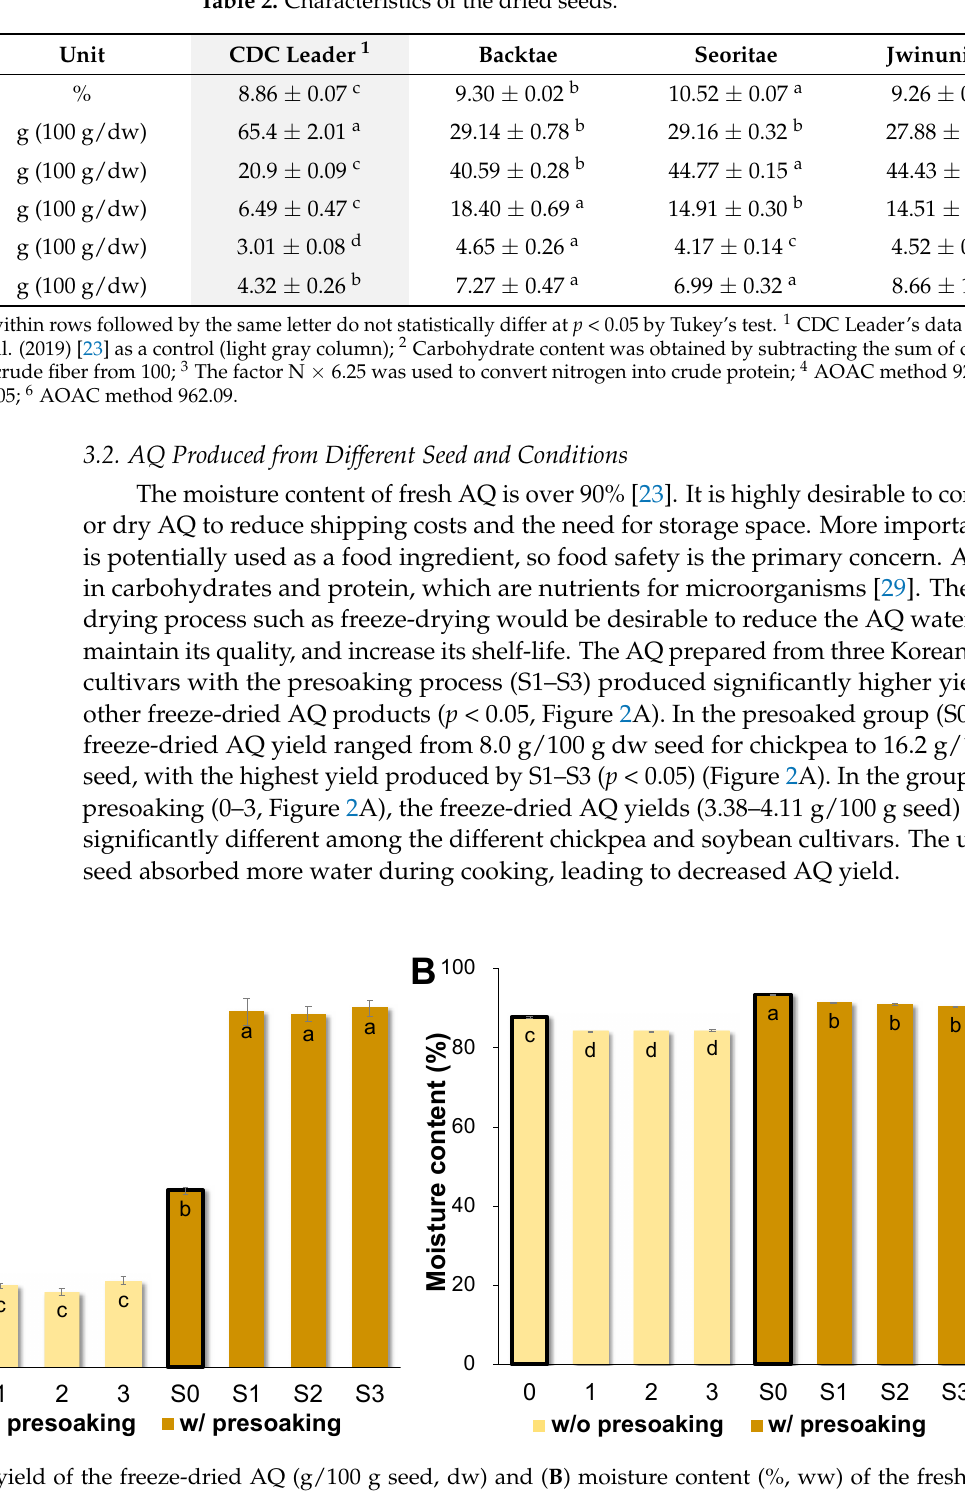
Figure 2. ( A ) The yield of the freeze-dried AQ (g/100 g seed, dw) and ( B ) moisture content (%, ww) of the fresh AQ prepared from different soybean cultivars and cooking conditions. Bold bar graphs are each group of controls (0 and S0), respectively. Values followed by different letters (a–d) within a property are significantly different ( p < 0.05) according to Tukey’s test.